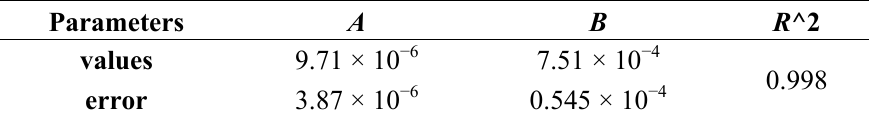
Table 3. Regression parameters for Raman